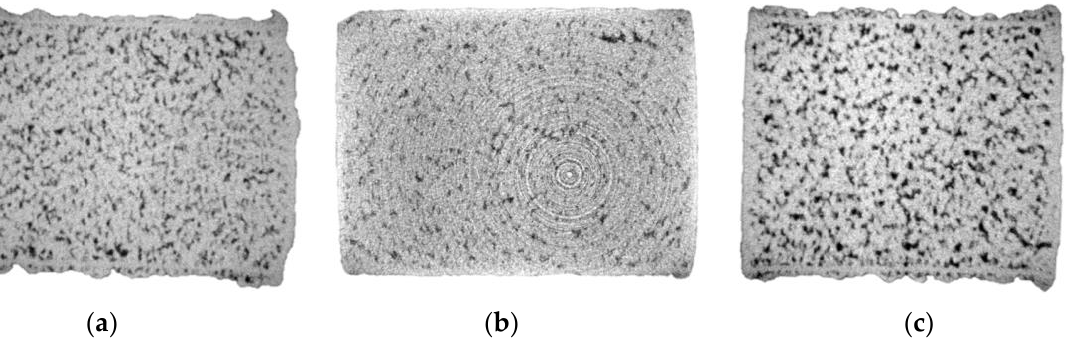
Figure 5. Computed Tomography data for high-purity Cu, where ( a ) is EOS Cu, ( b ) is Carpenter Additive Cu and ( c ) is EOS CuCP.